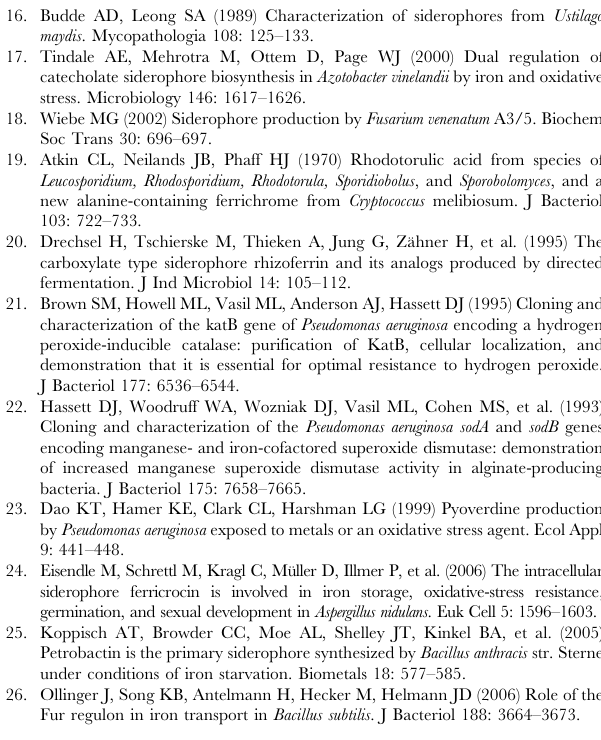
Gene name and number